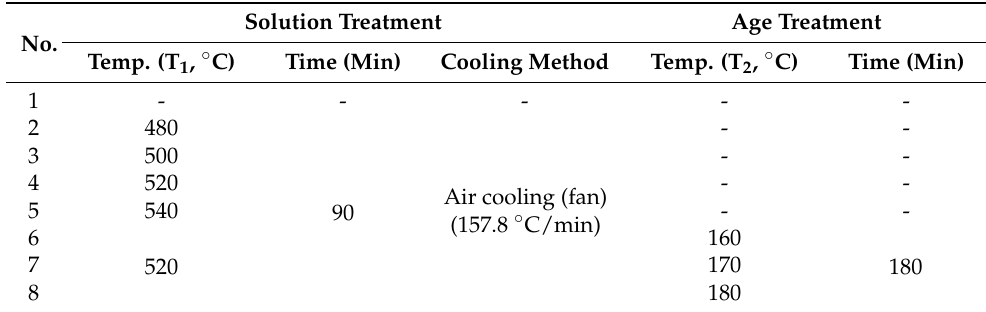
Figure 2. Schematic of the solution treatment and artificial aging treatment. Table 1. Chemical composition (wt.%) of the alloy used in this study.